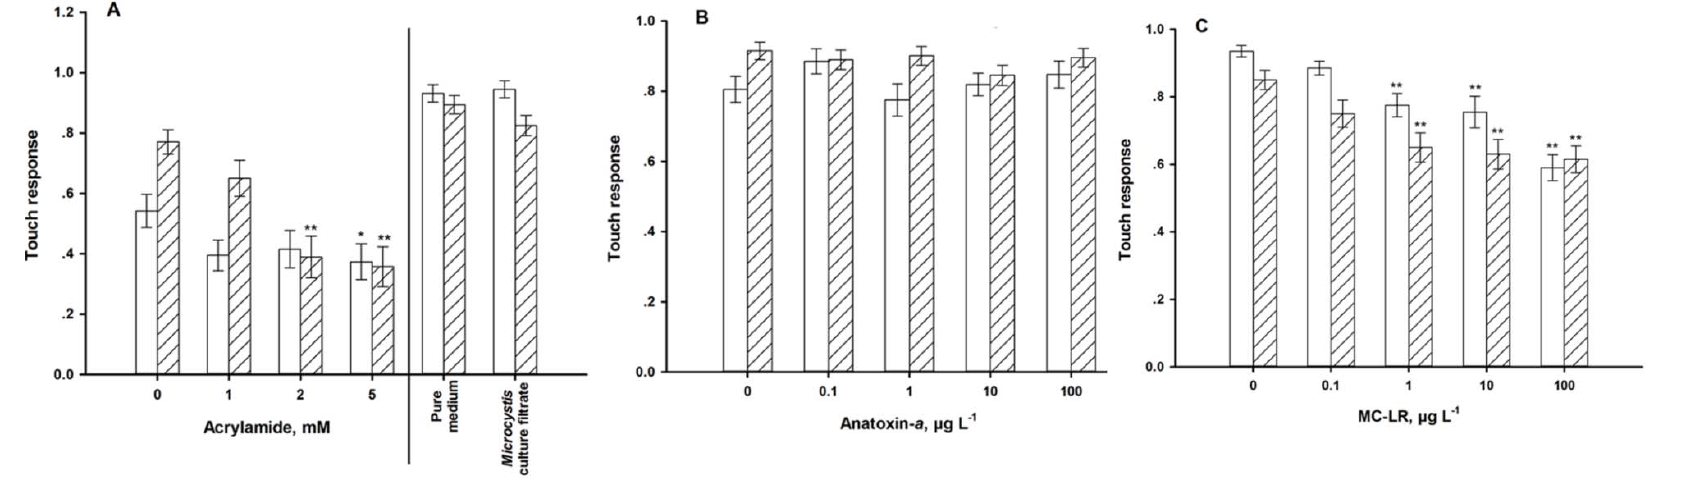
Figure 9. Mechnical sensory function of young adults for 24 h ( white ) and 72 h ( hatched ). ( A ): exposure to acrylamide and a Microcystis culture filtrate. ( B ): exposure to anatoxin- a . ( C ): exposure to microcystin-LR. * = p < 0.05, ** = p <